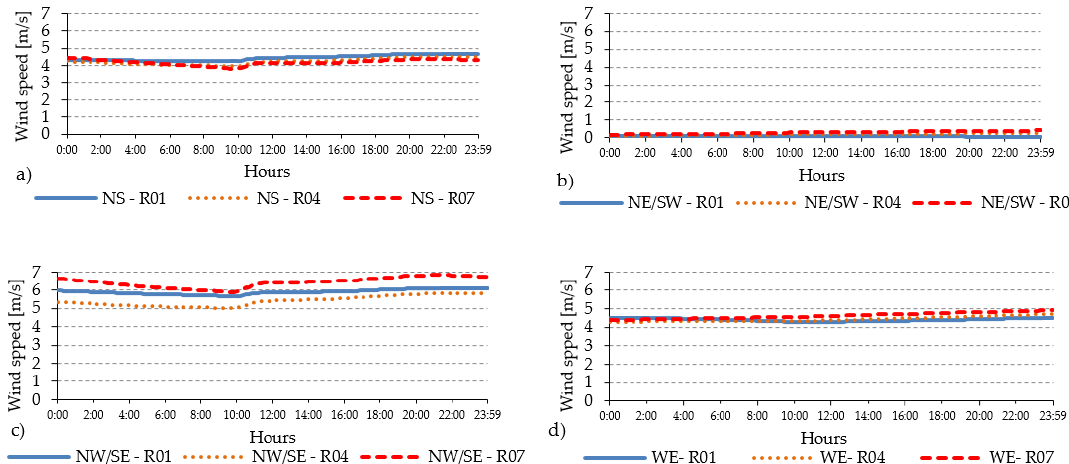
Figure 10. Spatial differences inside the UC of the compact mid-rise urban: the hourly evolution of the W s for different orientations ( a ) NS; ( b ) NE/SW; ( c ) NW/SE and ( d ) WE for R01, R04) and at R07.